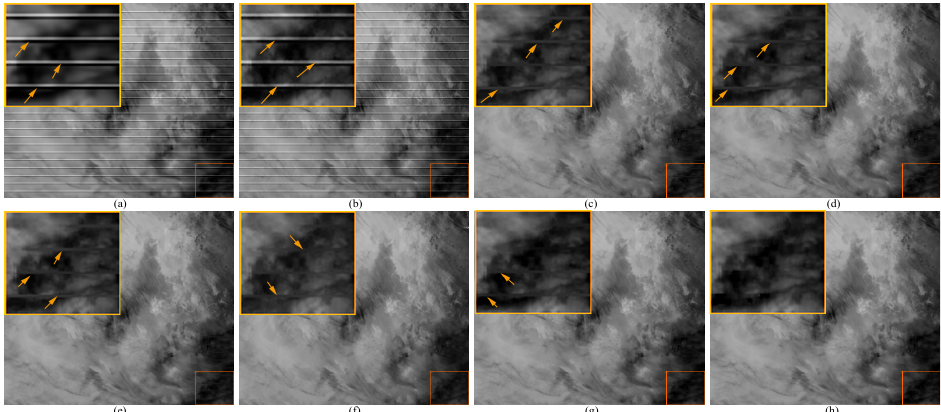
Figure 8. Results of comparison methods for simulated stripe Terra MODIS data S2. ( a ) BM3D;